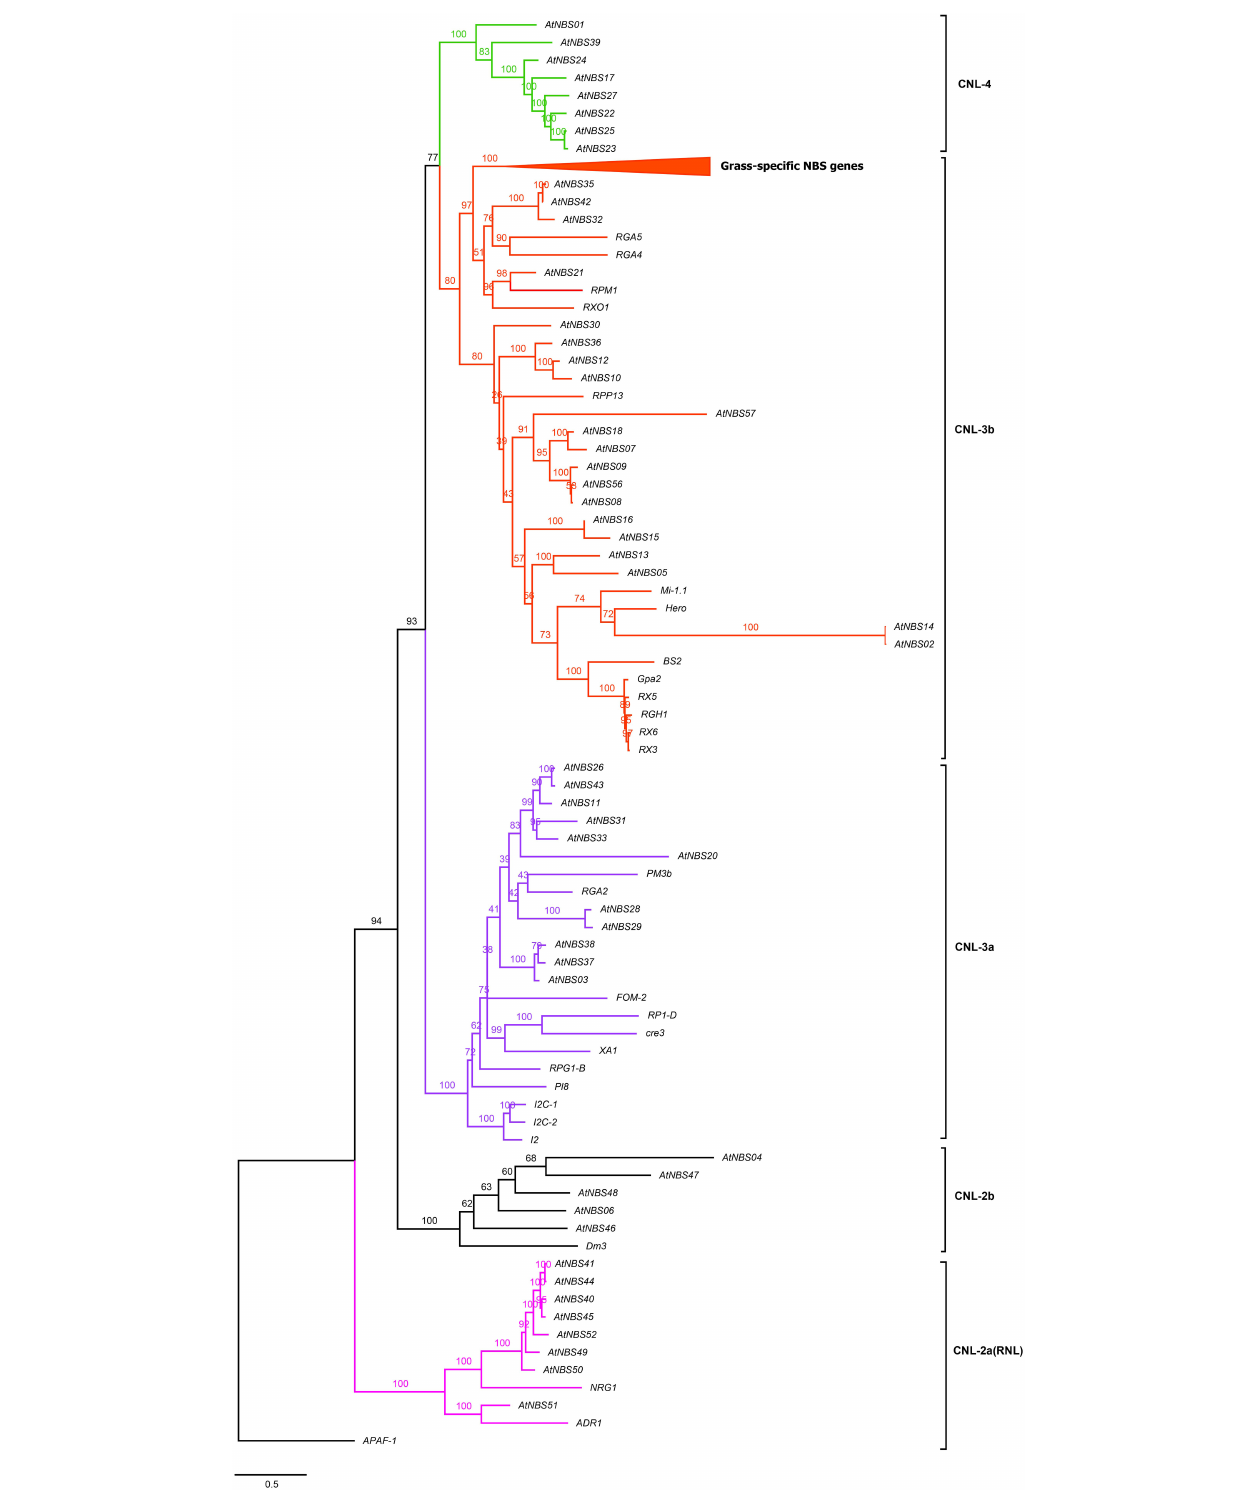
Frontiers in Plant Science |